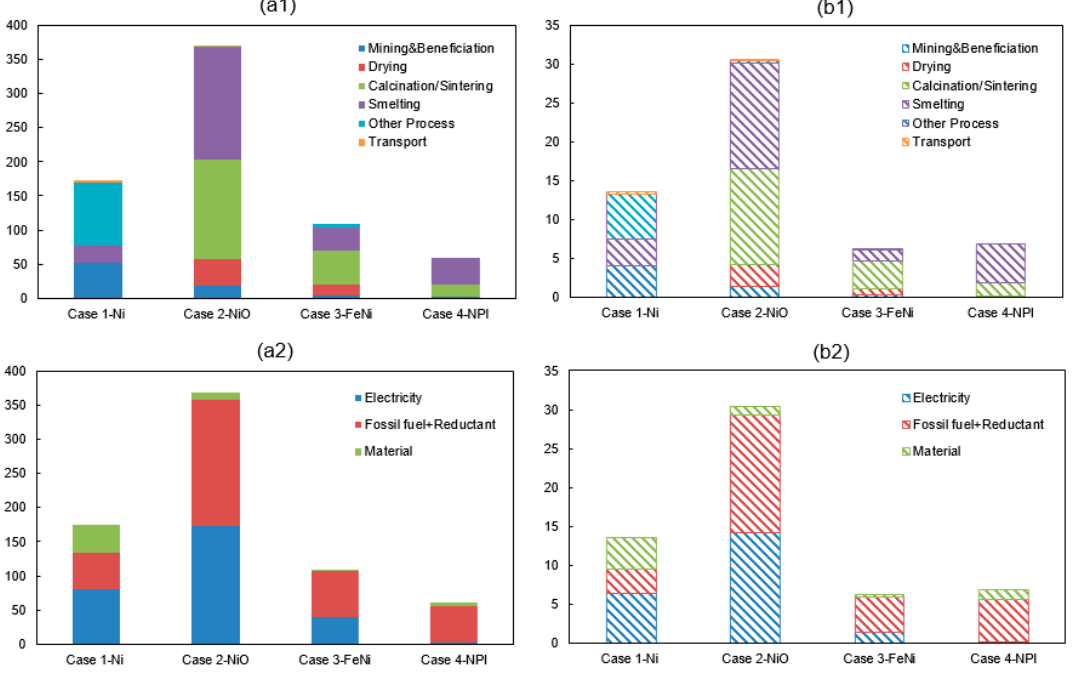
Figure 2. ( a1 ) Energy consumption (GJ / t alloy) and ( b1 ) GHG emissions (tCO 2 -eq / t alloy) of nickel production along with sub-process ( a2 ) Energy consumption (GJ / t alloy) and ( b2 ) GHG emissions (tCO 2 -eq / t alloy) of nickel production along with the contribution source.